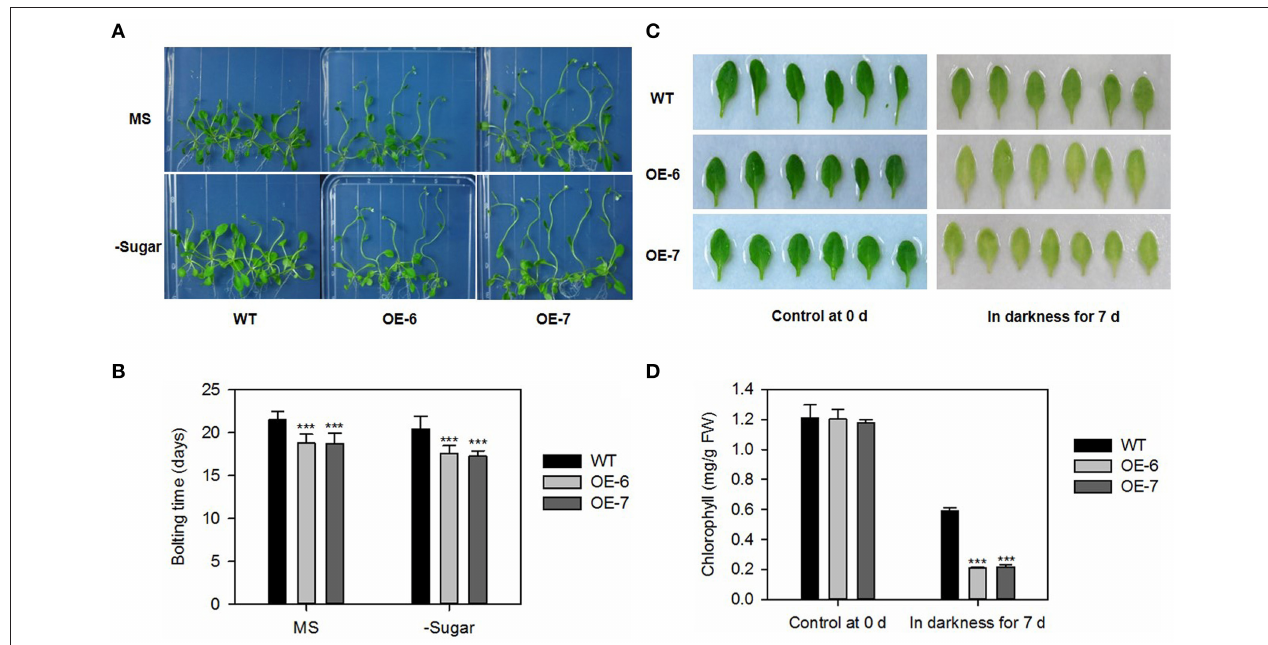
FIGURE 7 | Bolting and dark-induced leaf senescence is promoted by heterologous expression of MdATG8i in Arabidopsis. (A) Bolting comparison between WT and OE lines on Day 25; (B) Statistical analysis of bolting time. Data are means ± SD of 18 replicates; (C) Representative samples of control and dark-treated tissue from WT and OE lines; (D) Chlorophyll contents. Data are means ± SD of five replicates. * , ** or *** indicates the statistically significant differences determined by Student’s t -tests at P < 0.05, P < 0.01, or P < 0.001,